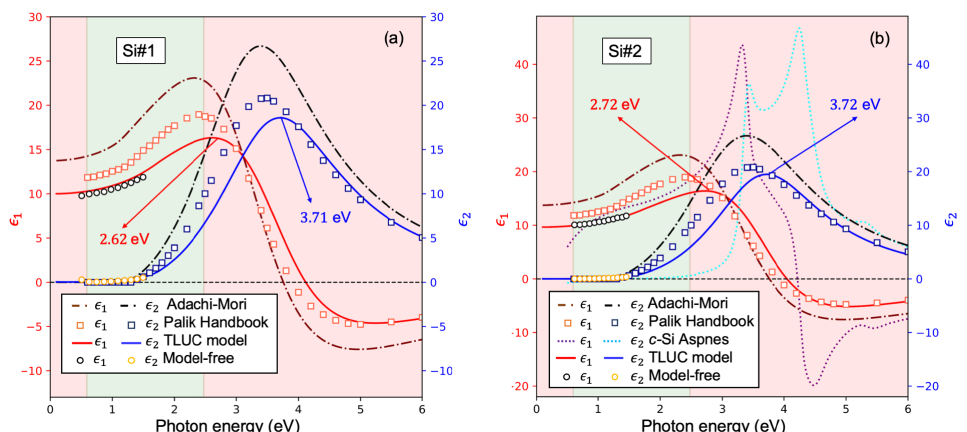
Figure 8. Real ( (cid:101) 1 ) and imaginary ( (cid:101) 2 ) parts of the complex dielectric functions versus photon energy, determined from the normal-incidence spectral transmittance, of the two representative RFMS- a -Si thin layers; ( a ) Si#1 and ( b )